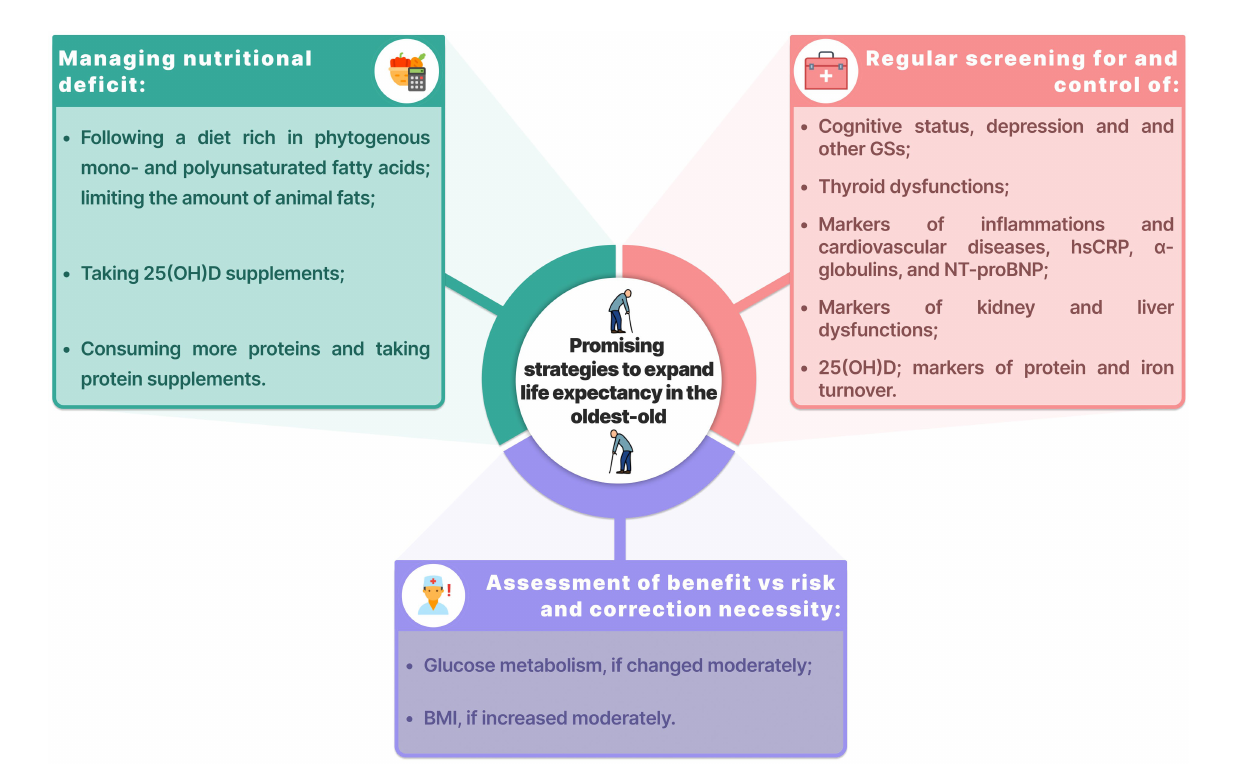
FIGURE 5 Promising strategies to expand life expectancy in the oldest-old. BMI, body mass index; GSs, geriatric syndromes; hsCRP, high-sensitivity C-reactive protein; NT-proBNP, N-terminal pro b-type natriuretic